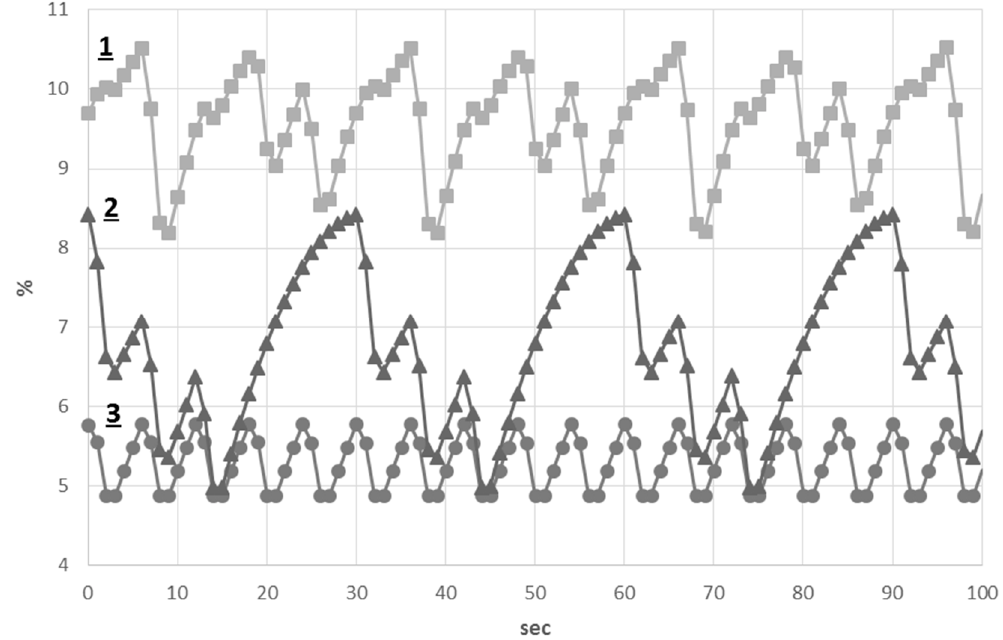
CO : (1) Periodic breathing; (2) Cluster breathing; (3) normal Figure 5. Alveolar concentration of Figure 5. Alveolar concentration of CO 2 : (1) Periodic breathing; (2) Cluster breathing; (3) normal 2 breathing.